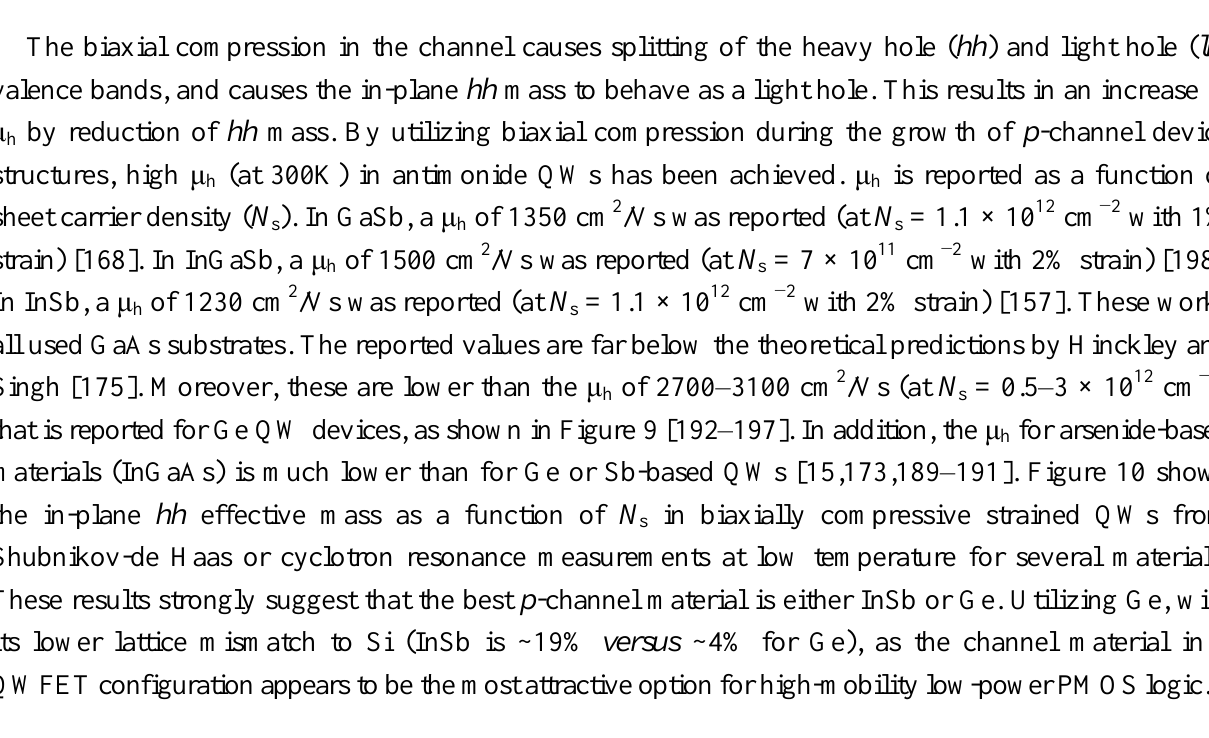
Figure 10. Effective mass vs . sheet carrier density in biaxially compressed